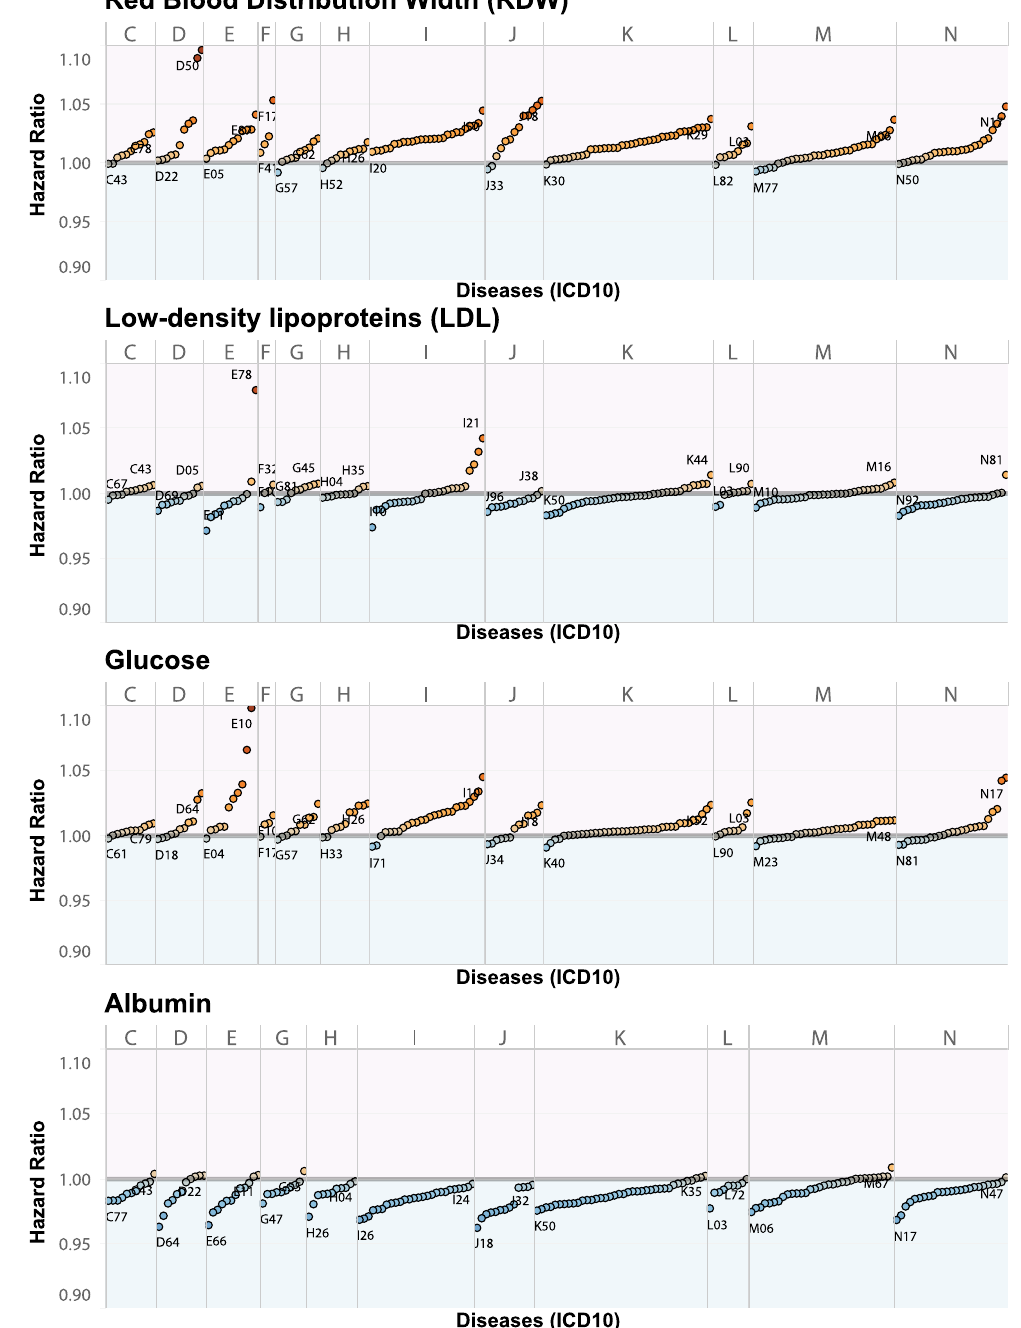
Figure 1. Trends for selected biomarkers hazard ratios across 209 diseases stratified by ICD10 class. Each dot represents a multivariate-adjusted CoxPH hazard ratio of a biomarker-disease association. Diseases are sorted from low to high risk within each ICD class with increased risk colored in red, and reduced risk colored in blue. The lowest and highest hazard disease within each class is labeled. Red Blood Distribution Width (RDW) is a risk factor for most diseases, Albumin is primarily associated with reduced risk across the whole disease space, and Glucose and low-density lipoprotein (LDL) showed mixed patterns. Diseases with the highest risk and lowest risk are marked by their ICD10 code. Elevated RDW is a predictor of iron deficiency anemia (D50). Elevated LDL is a risk factor for the development of acute myocardial infarction (I21). Elevated glucose is a risk for the development of insulin-dependent diabetes